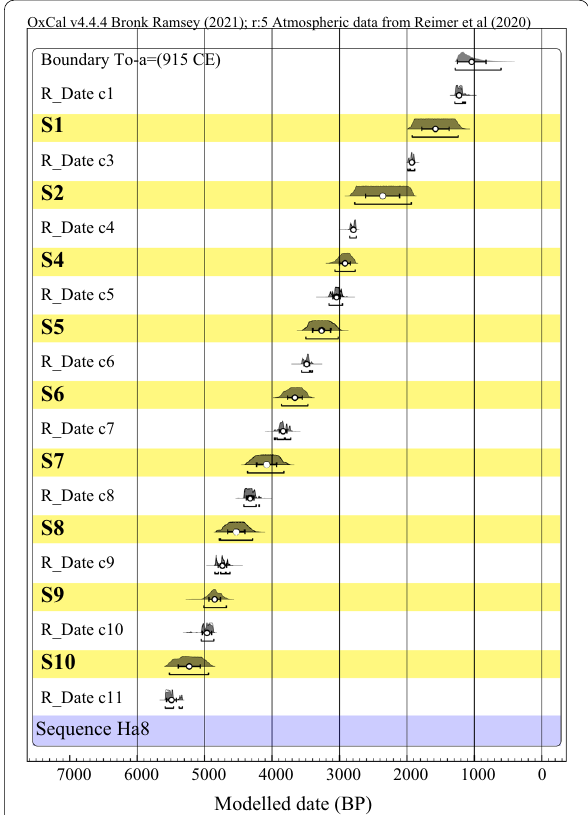
Fig. 12 Calibrated 14 C dating results and modeled dates for samples obtained from core sample Ha8. Modeled dates are shown with a probability of 95% (2σ). R_Date curves correspond to each calibrated sample result. Yellow stripes denote the calculated deposition ages for the sand layers. Sequence model is bounded by To‑a tephra event